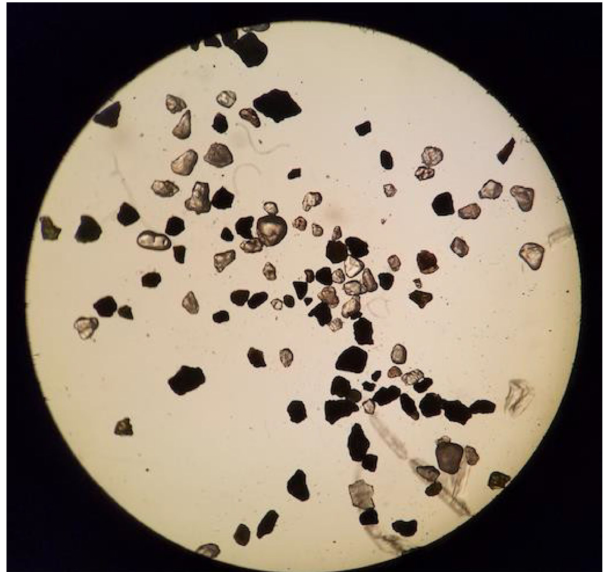
Figure 7. Sample of mixed sand grains (ca. 55% stamp sands) under a microscope’s transmitted light. Image shows the contrast between rounded, transparent quartz grains of natural sand and the dark (opaque), fragmented grains of stamp sands